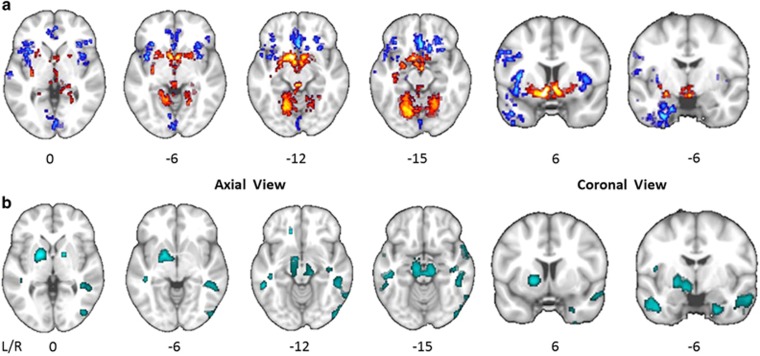
Whole brain maps of significant group differences. (a) Group comparison of modulated gray matter volume at whole brain level. Voxels colored in blue indicate brain areas in which patients with cocaine use disorder (CUD) have reduced gray matter volume compared with control volunteers, and voxels colored in red indicate brain areas in which CUD patients have abnormally increased gray matter volume. The statistical results are overlaid on the FSL MNI152 standard T1-image and the numbers beneath each section of the image refer to its position (mm) relative to the inter-commissural plane in standard stereotactic space. (b) Group comparison of iron concentration as estimated by quantitative susceptibility mapping (QSM) at whole brain level. Clusters colored in turquoise indicate greater iron concentration in CUD patients compared with control volunteers.